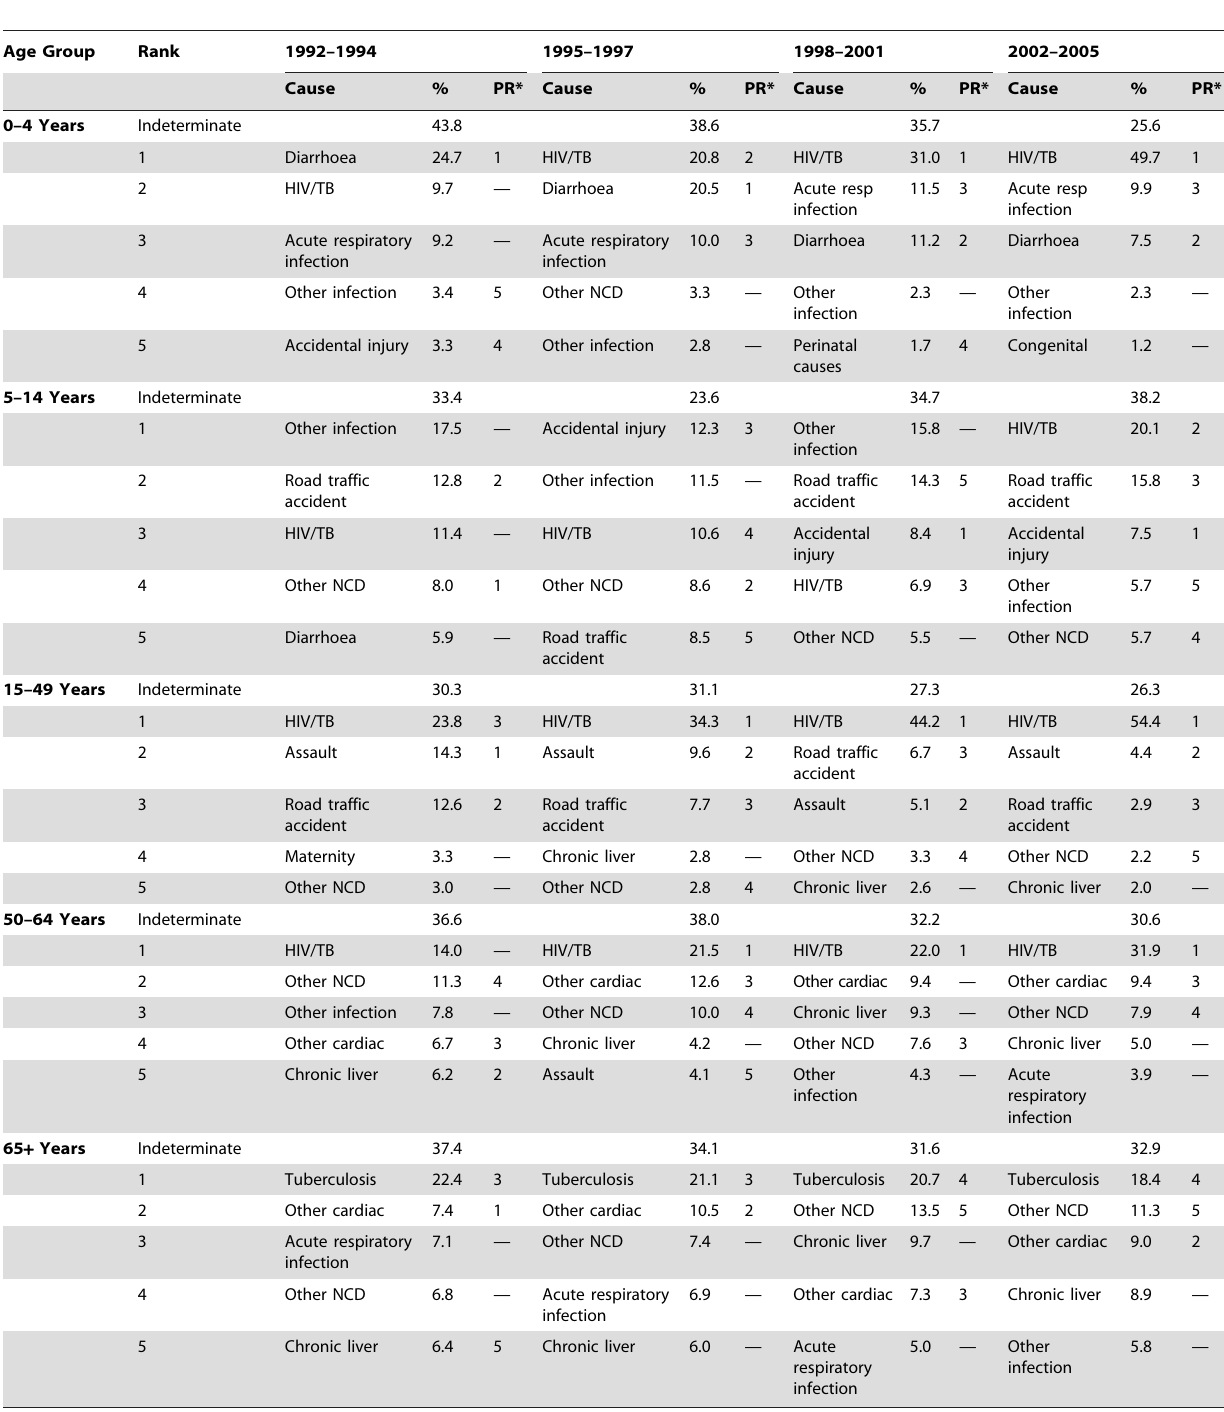
Table 2. Five main causes of death by age group and time period, based on 6,153 deaths in Agincourt HDSS occurring between 1992 and 2005, using cause of death as interpreted probabilistically by the InterVA 3